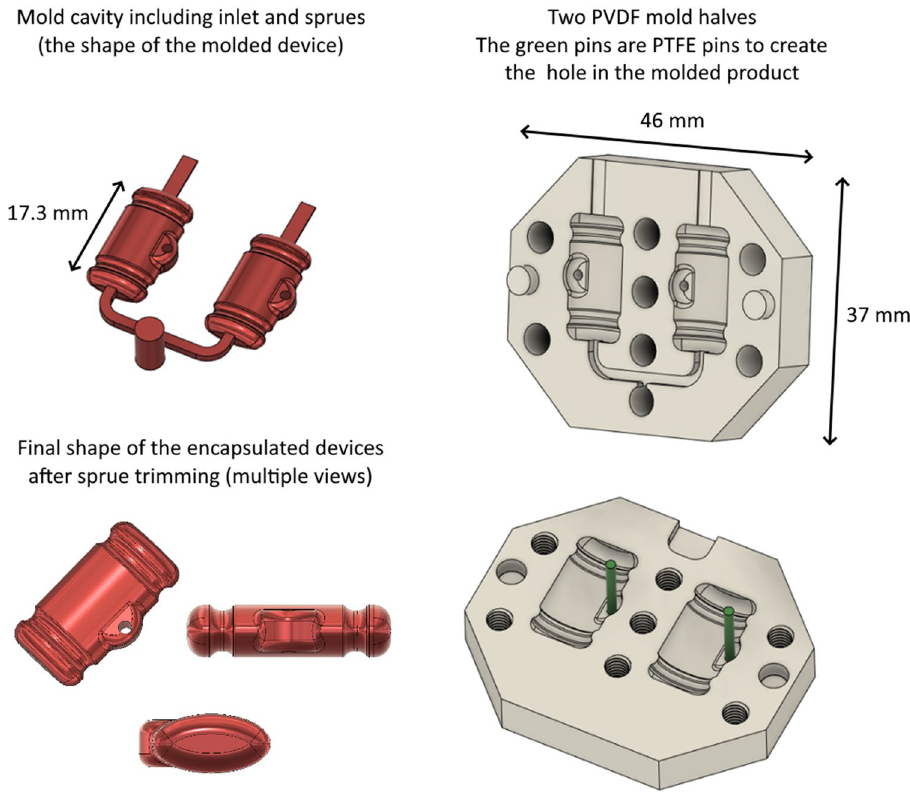
Figure 2. Injection mold